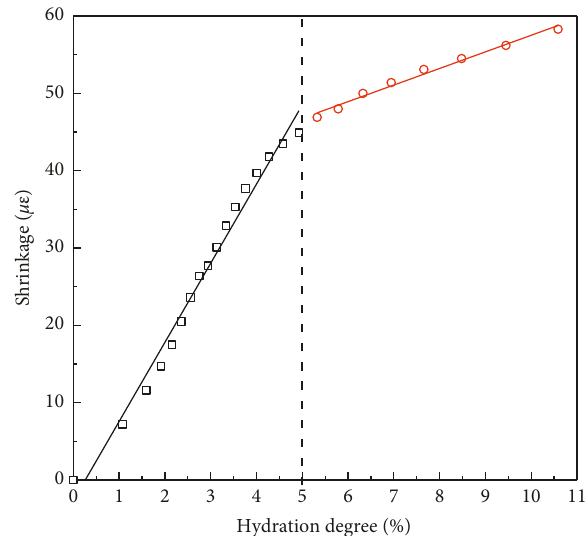
Figure 3: The fitting curve of hydration degree and chemical shrinkage.